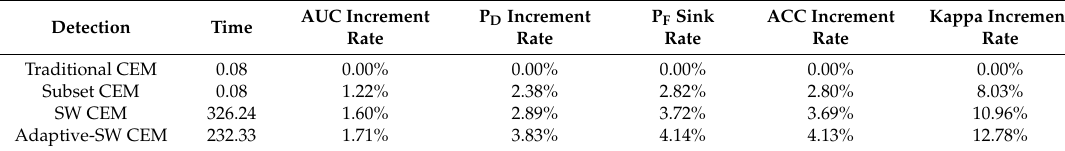
Table 8. Computing time of different algorithms and CEM